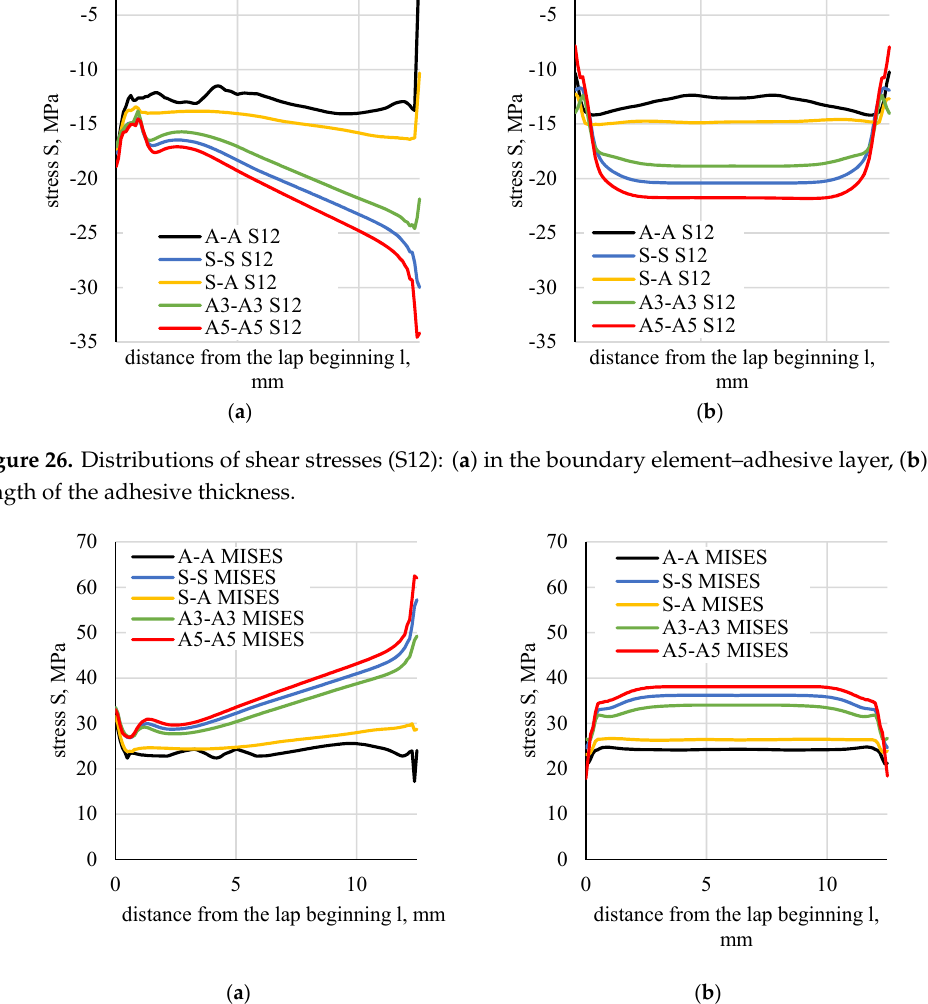
Figure 27. Distributions of stresses, reduced according to the Huber–Mises hypothesis: ( a ) in the boundary element–adhesive layer, ( b ) halfway of the adhesive thickness. Maximal values of the calculated distributions for the element–adhesive boundary layer are presented in the form of column diagrams (Figure 28) and the same for the layer halfway of the adhesive thickness (Figure 29).